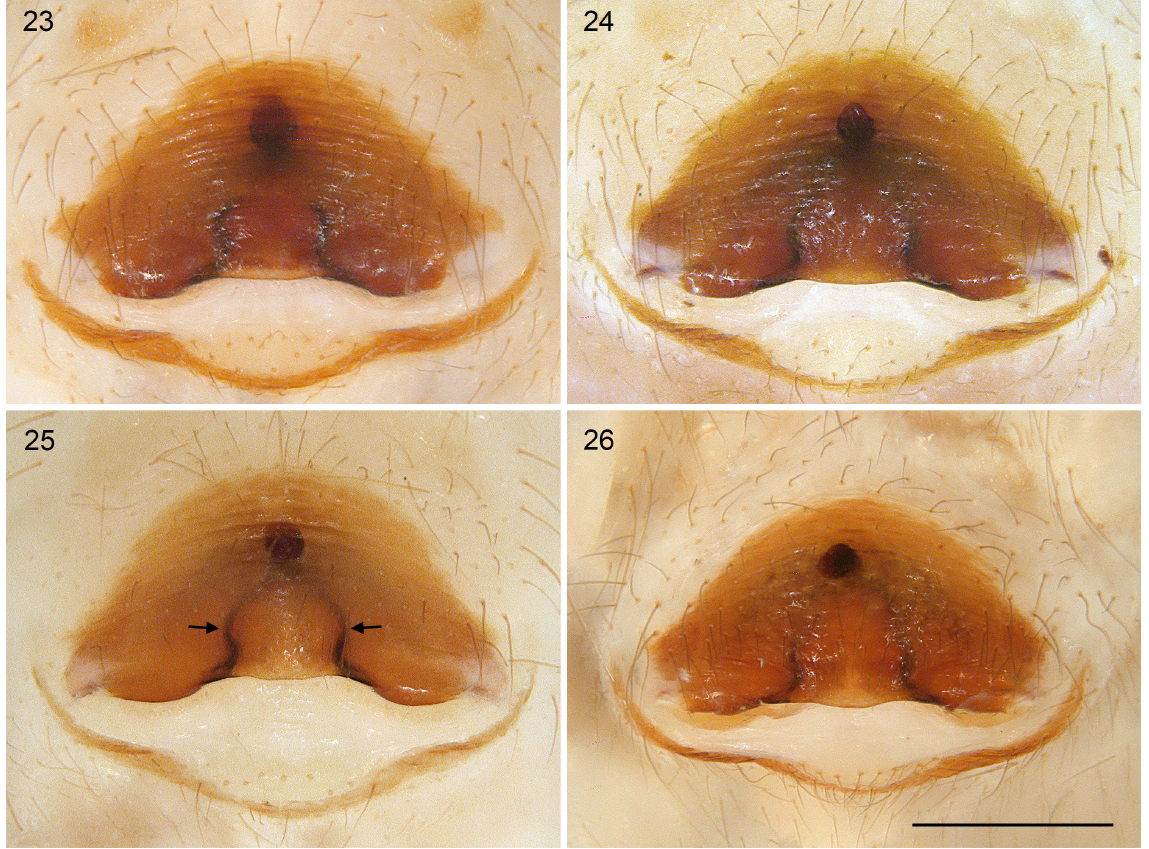
Figs 23–26. Stygopholcus absoloni (Kulczyński, 1914); epigyna, ventral views. 23 . Balićeva špilja, Croatia (ZFMK (Ar 22195)). 24 . Biokovo, Kukor, Croatia (CBSS (Ar 3367)). 25 . Studenci (grotte), Bosnia and Herzegovina (MHNG); arrows point at distinctive internal sclerites. 26 . Vjetrenica, Bosnia and Herzegovina (ZFMK (Ar 22192)). Scale bar: 0.5 mm (all at same